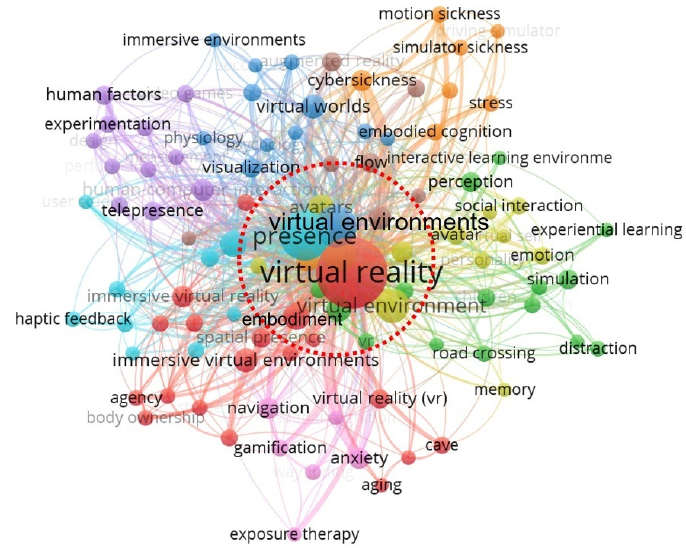
Figure 14. Virtual reality—embodiment–presence continuum.